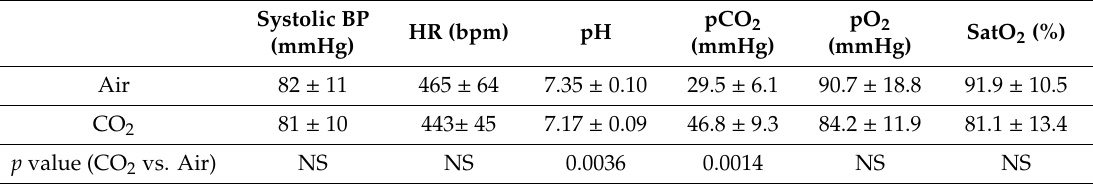
Table 4. Systolic arterial blood pressures (BP), heart rates (HR) and pH, arterial CO 2 and O 2 partial pressures and O 2 saturation in anaesthetized (0.5% isoflurane) adult control mice under air and / or 5% CO 2 -16% O 2 -79% N 2